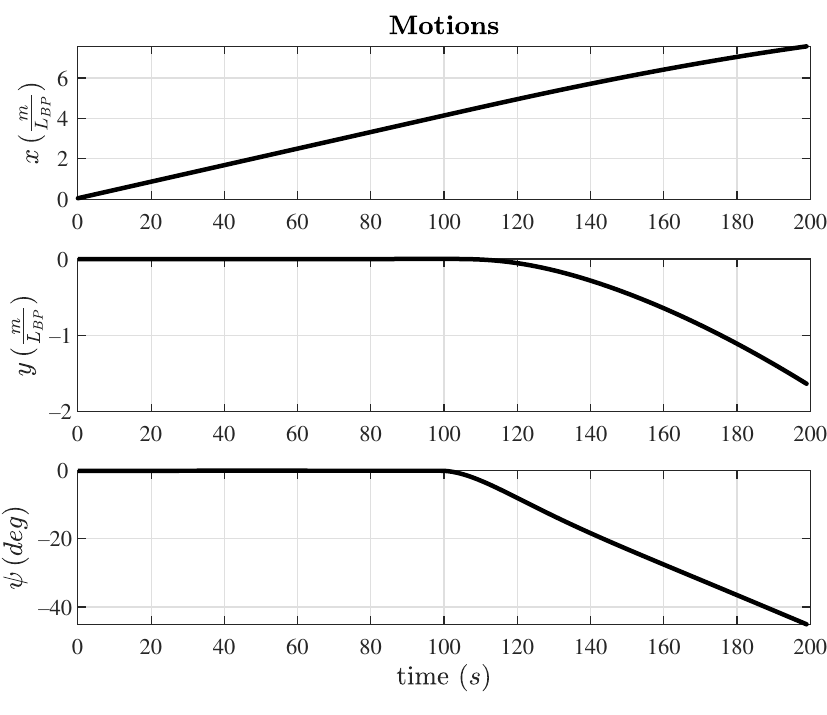
Figure 10. Vessel